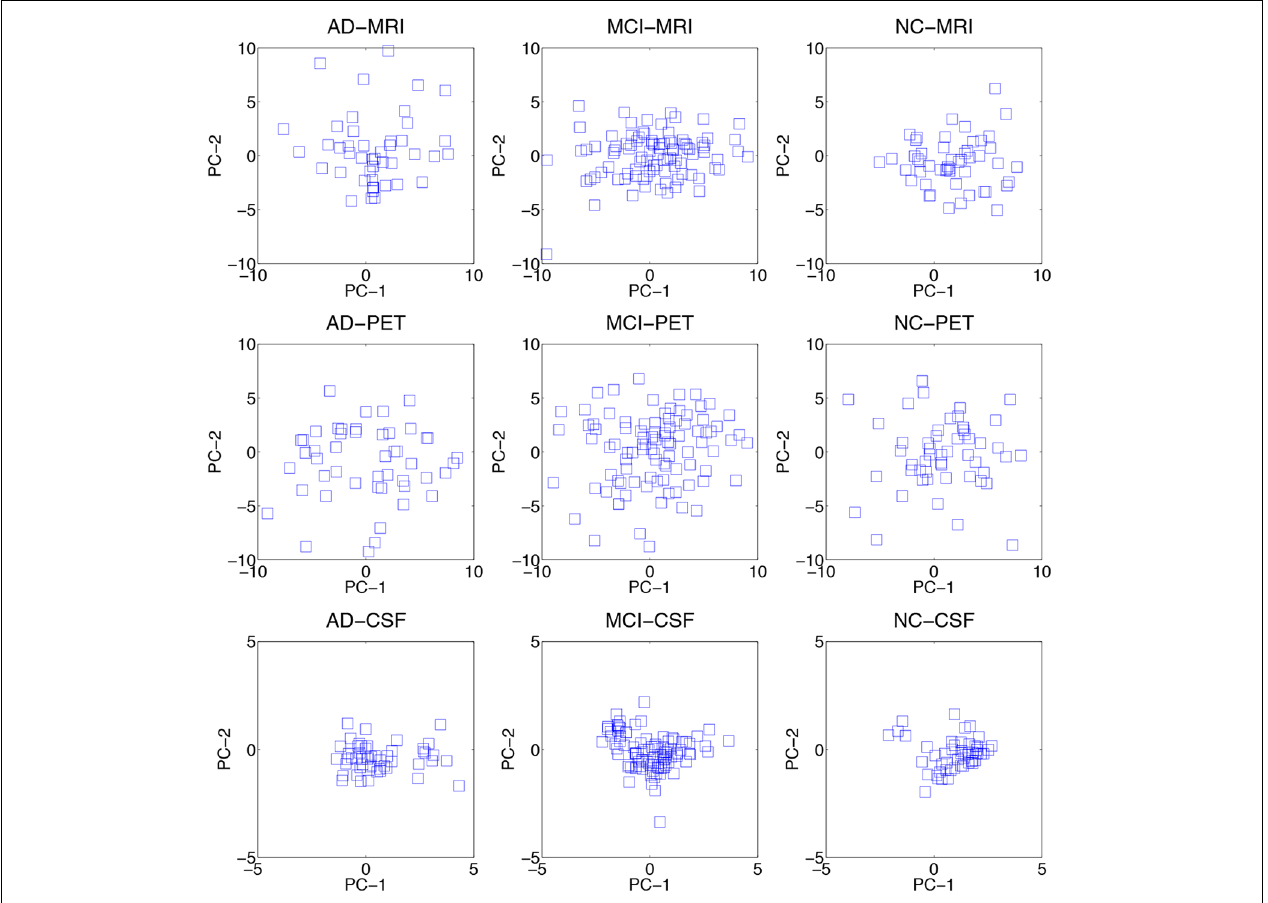
FIGURE 3 | Data distributions of three modalities over different disease labels. For visualization, we transformed the original features in an ambient space into their respective 2D eigenspace, whose bases (PC-1 and PC-2) were obtained via principal component analysis.